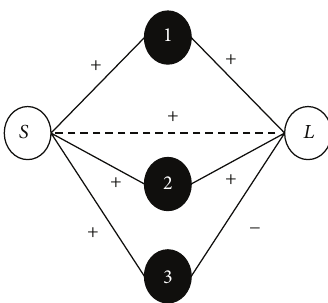
Figure 2: The coupling scheme of proposed triple-mode